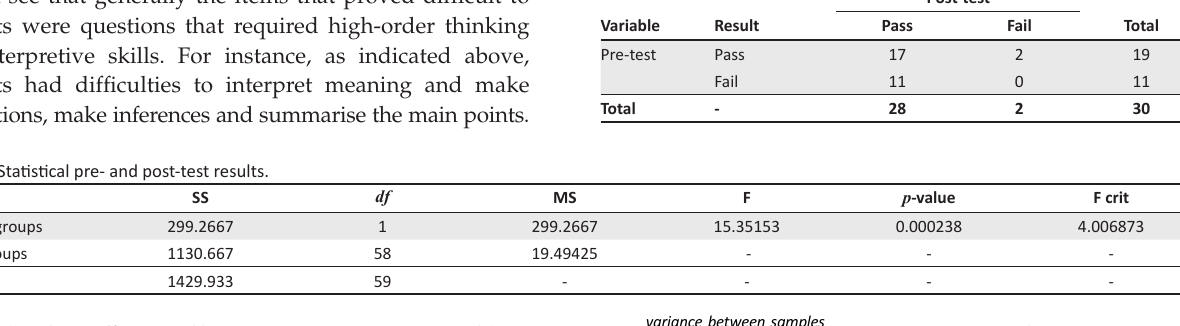
TABLE 2: Comparison of students’ performances in the pre- and post-entry tests. Variable